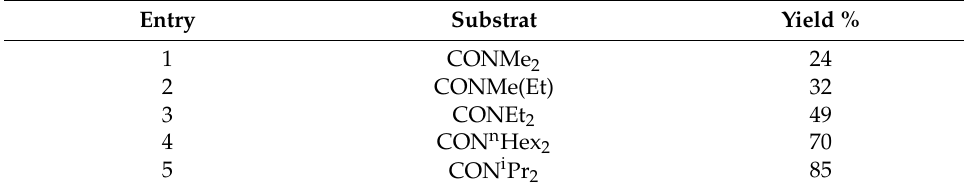
Table 1. Directing groups